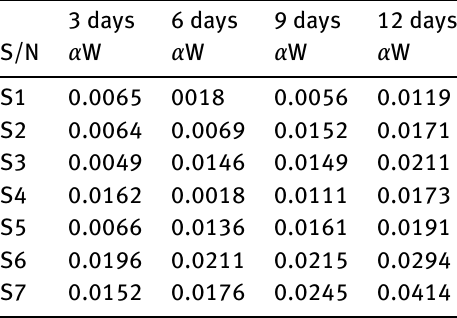
Figure 3: Plot of S3 (Inhibition eflciency versus Time of inhibition (days).